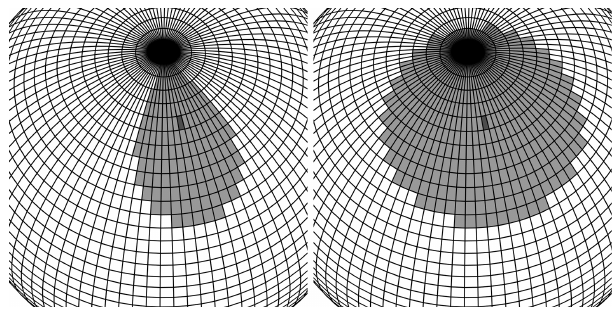
Figure 2. Grid cells on a latitude–longitude mesh whose centroids are within 30 ◦ of a cell at 68 ◦ N latitude using latitude–longitude distance (left) and great-circle distance